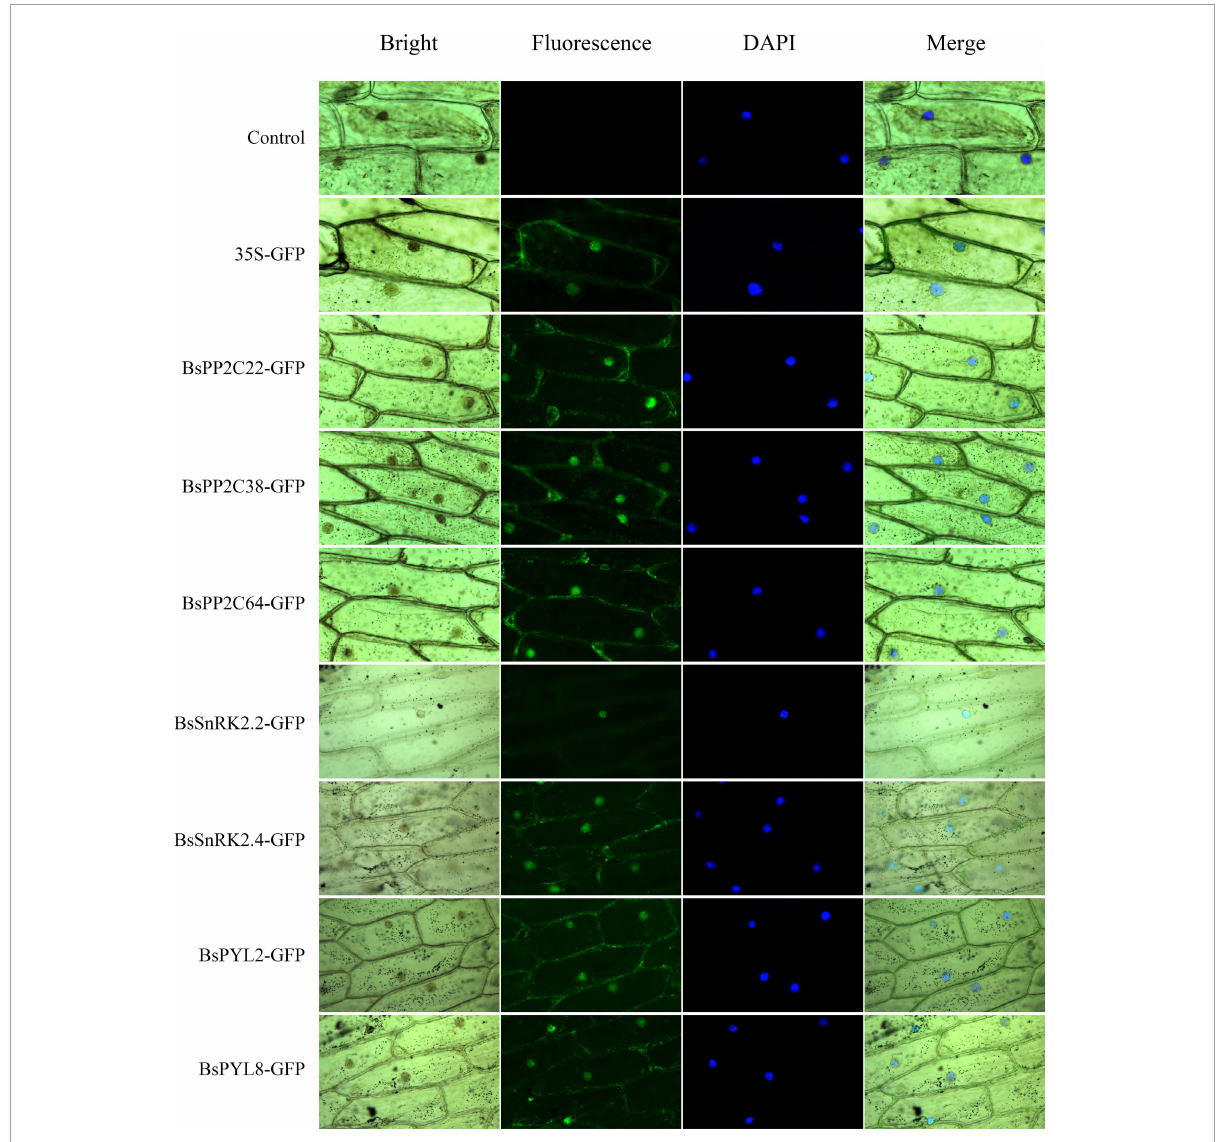
FIGURE6 Subcellular localization of BsPP2C22, BsPP2C38, BsPP2C64, BsSnRK2.2, BsSnRK2.4, BsPYL2, and BsPYL8 in onion epidermal cells. Green fluorescence was observed at ∼ 475 nm, and DAPI was observed at ∼ 350